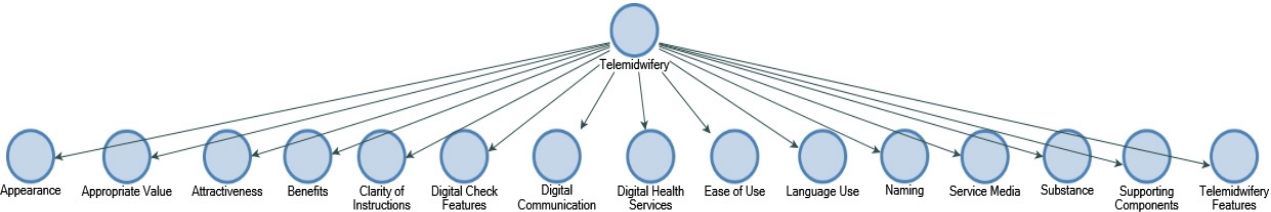
Figure 1. Qualitative Data Analysis Process.